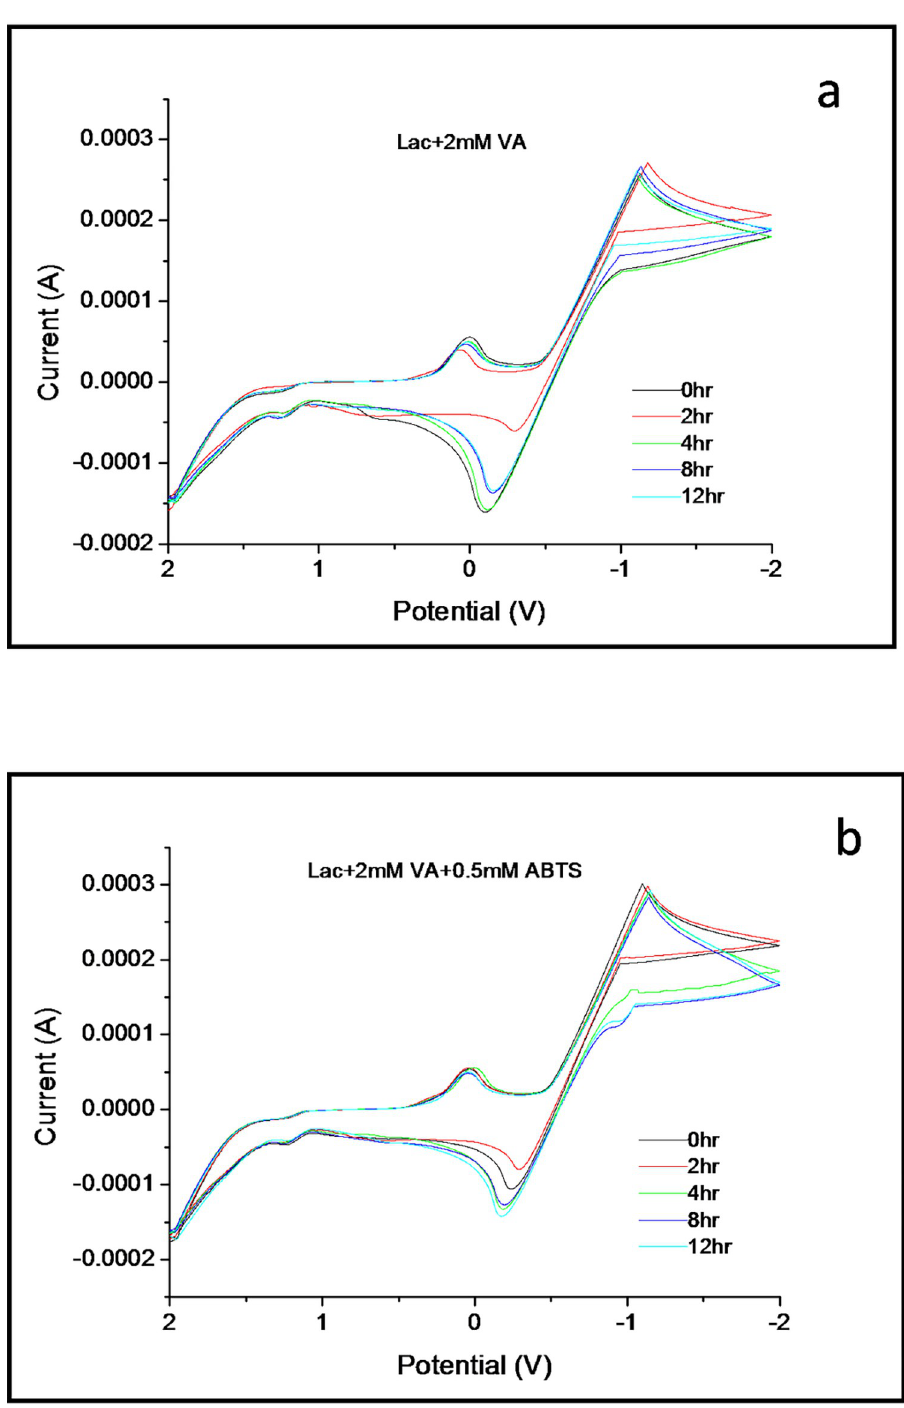
Fig 2. Cyclic voltammograms of VA (2mM) with Trametes versicolor laccase and the mediator ABTS (0.5mM) over 12 hours recorded in a buffered solution of pH 5 at a scan rate of 100mV/s.